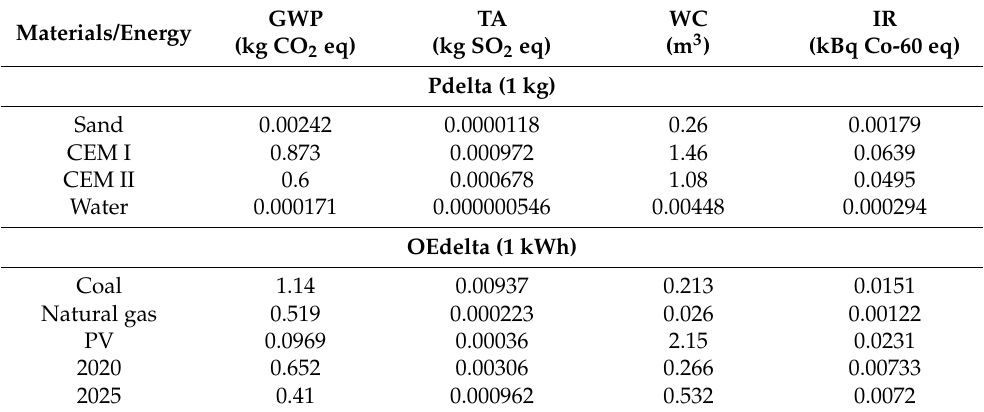
Table 5. Life-cycle impact based on evaluation of Pdelta and OEdelta of sculptured tiles (ReCiPe2016, hierarchist perspective [18]).